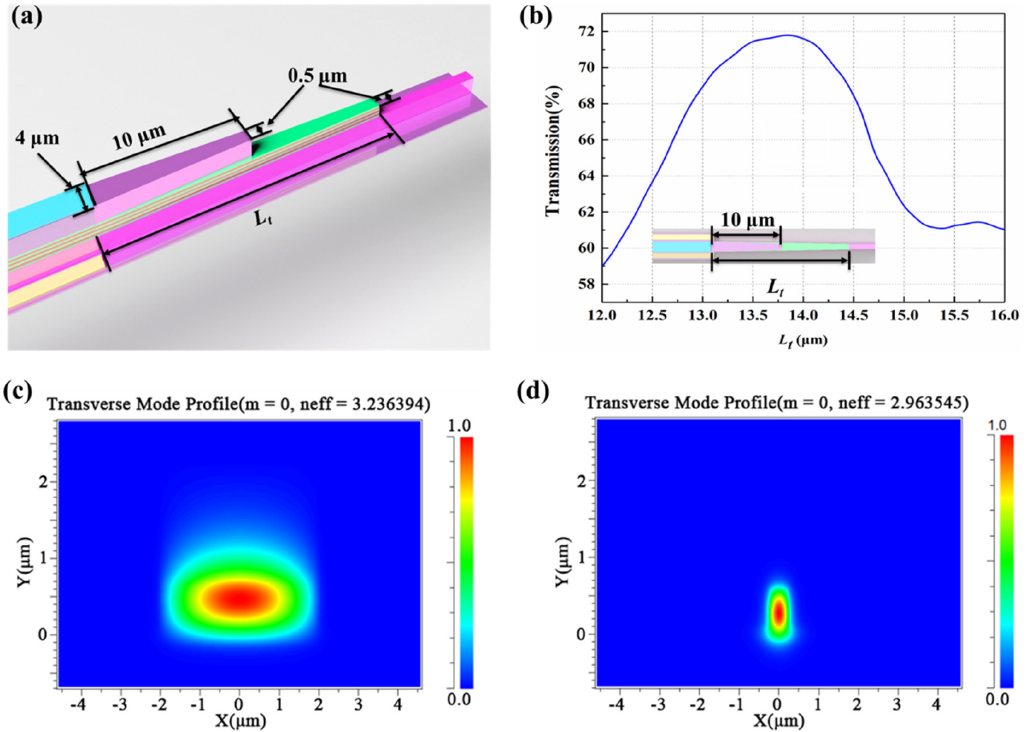
Figure 5. ( a ) The stepped trapezoidal coupling structure between the F-P quantum well laser and InP waveguide. ( b ) The relationship between transmission and the length ( L t ) of the trapezoidal quantum well and InP waveguide. ( c ) Cross-section optical field distribution of the input region. ( d ) Cross-section optical field distribution of the output InP waveguide.